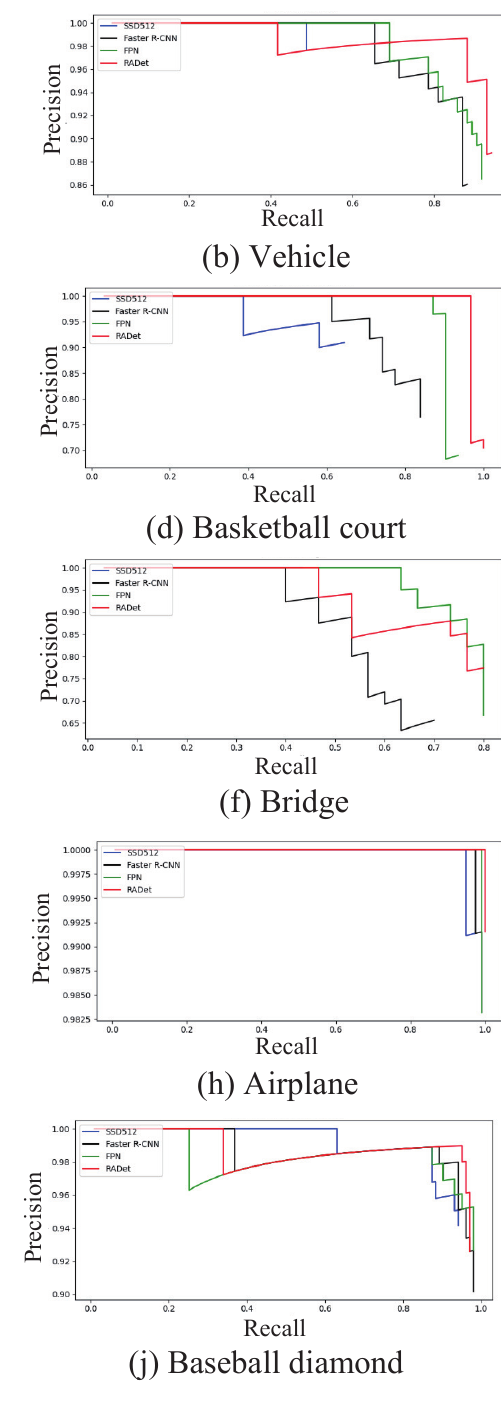
Figure 8. The P-R curves of RADet and other classical object detection algorithms on NWPUVHR 10 dataset. ( a ) P-R curves on Tennis court category. ( b ) P-R curves on Vehicle category. ( c ) P-R curves on Harbor category. ( d ) P-R curves on Basketball court category. ( e ) P-R curves on Ground track field category. ( f ) P-R curves on Bridge category. ( g ) P-R curves on Ship category. ( h ) P-R curves on Airplane category. ( i ) P-R curves on Storage tank category. ( j ) P-R curves on Baseball diamond